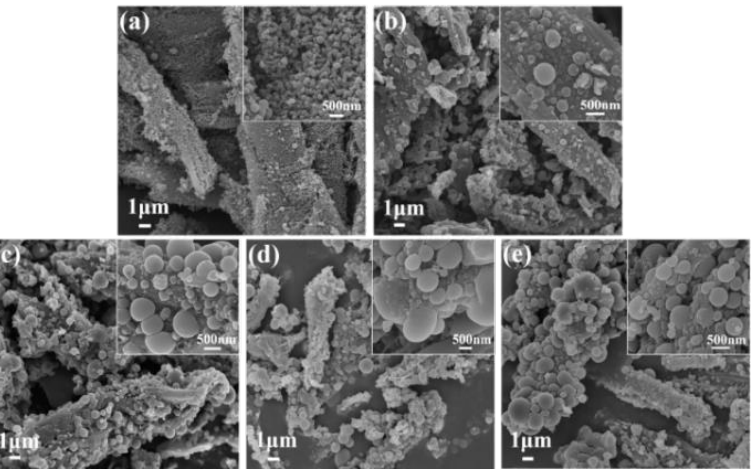
Figure 1. SEM images of the samples of HTC ( a ), HTC-N 3:1 ( b ), HTC-N 2:1 ( c ), HTC-N 1:1 ( d ), and HTC-N 1:2 ( e ).